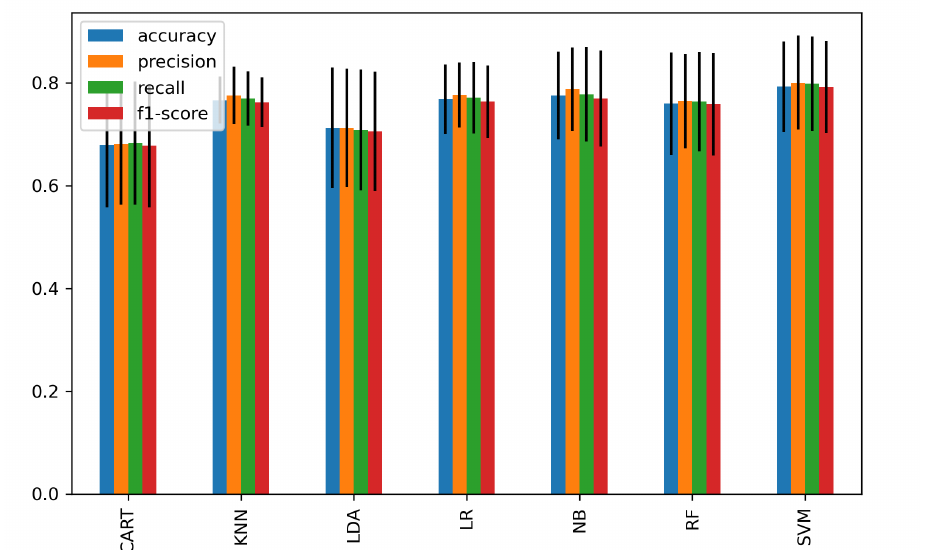
Figure 9. The average classification performance and standard deviation of 20 significant features from the frequency